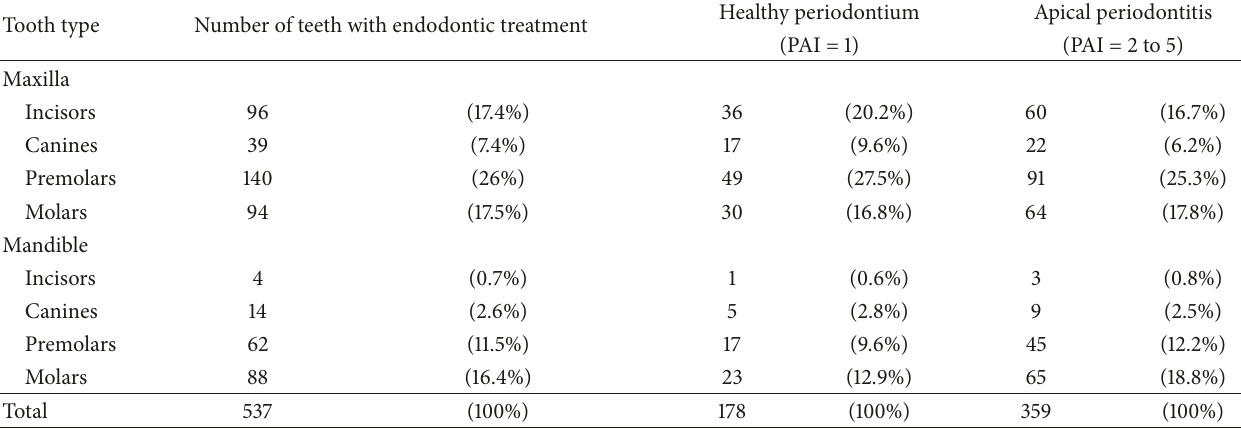
Table 3: Distribution of apical periodontitis and healthy periodontium according to the tooth type with endodontic treatment. Tooth